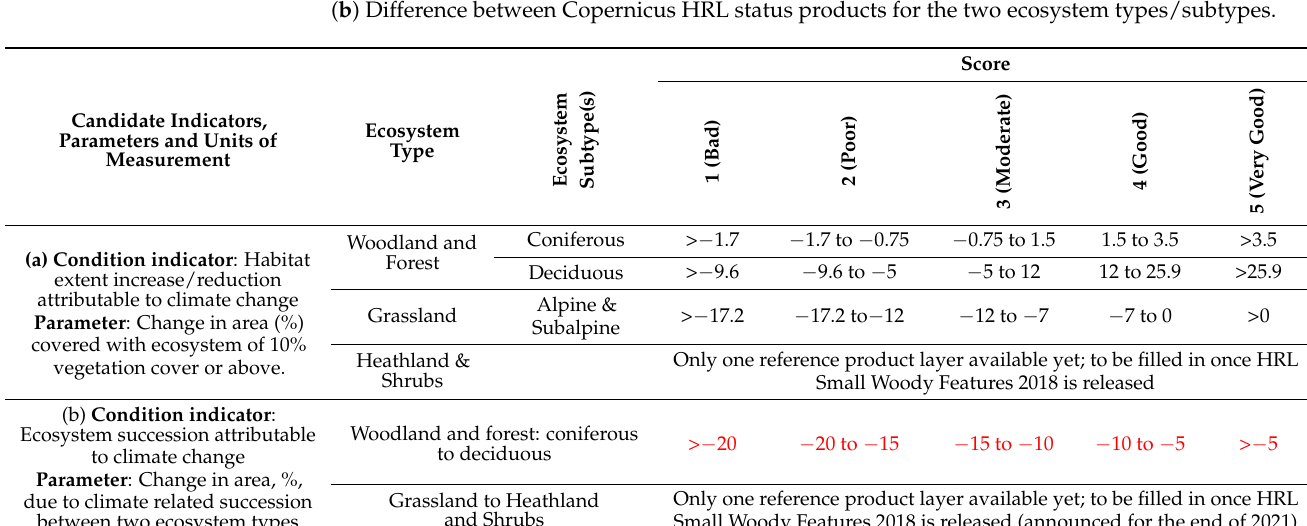
Table 2. Candidate indicators and their parameters proposed for inclusion in the terrestrial ecosystem ucts of two consecutive releases (every three years), with spatial resolution of 20 m per pixel or below; ( b ) Difference between Copernicus HRL status products for the two ecosystem